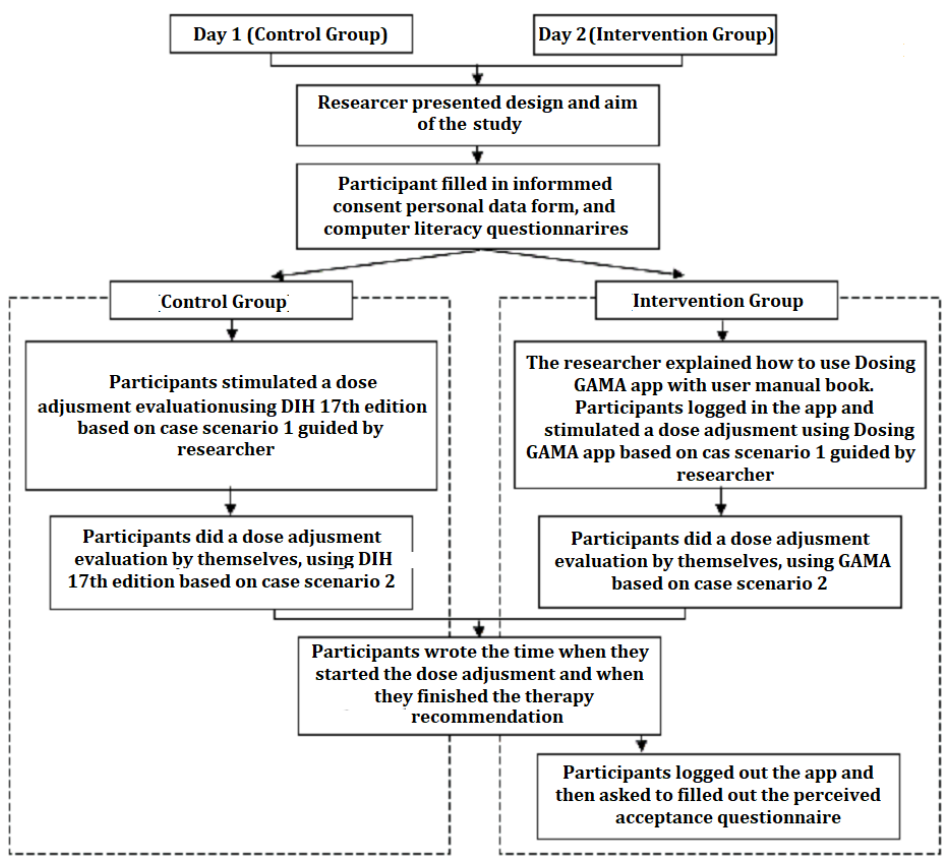
Figure 1. Data collecting process ( a Drug Informational Handbook 17 th Edition